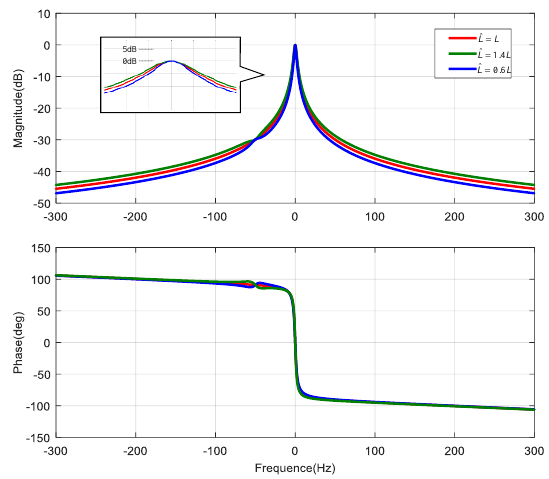
Figure 8. Complex vector FRF for variations in 𝐿̂ of the inverter with a cross-coupling decoupling synchronous frame PI current controller, shown in the synchronous reference frame.